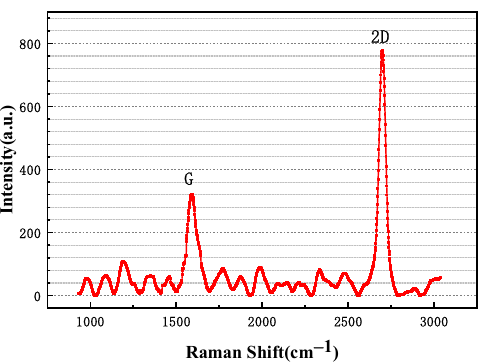
Figure 5. Raman spectrum of Copper foil covered with graphene at room temperature.